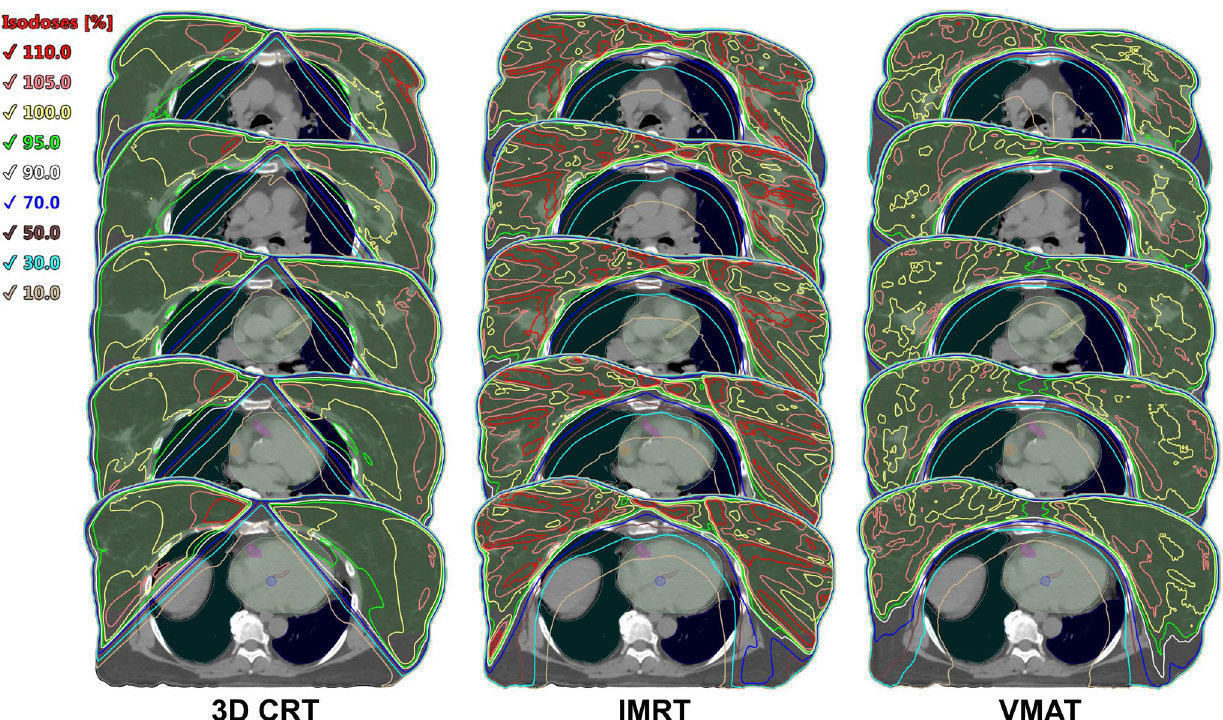
Fig. 3 The dose distribution examples of SBBC treatment plans using 3D CRT (on the left), IMRT (in the middle) and VMAT (on the right)